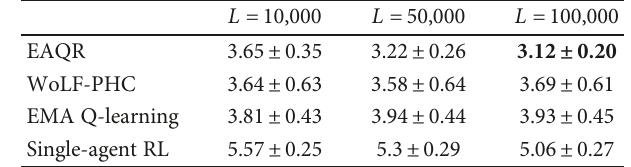
Table 5: Average cumulative reward for the DSN problem (evaluation episodes =5000).